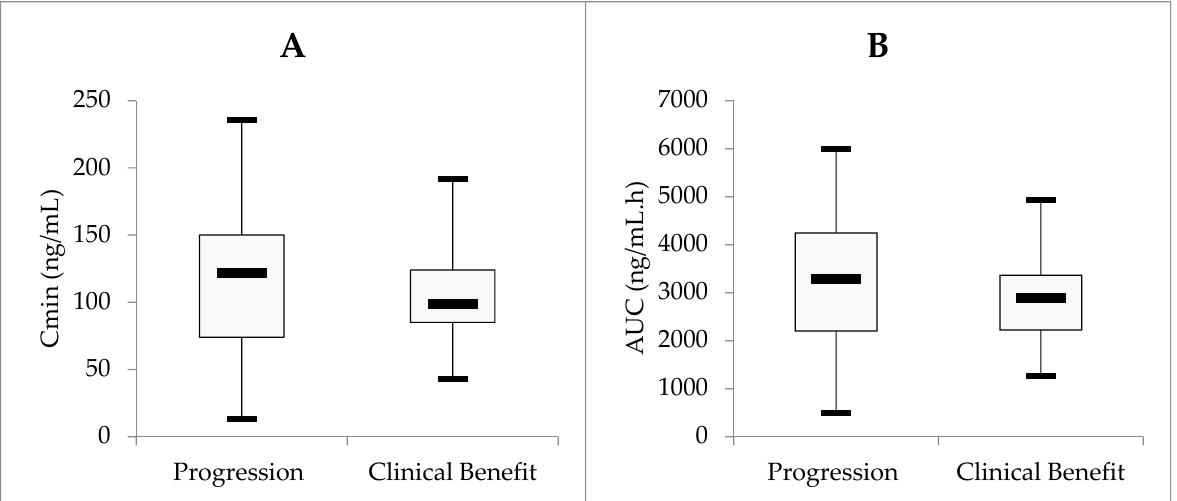
Figure 4. ( A , B ) Relationships between clinical issues and concentration trough levels ( A ) or drug exposure ( B ). No statistical difference was found in Cmin or AUC values between patients with clinical benefit and patients with progressive disease.